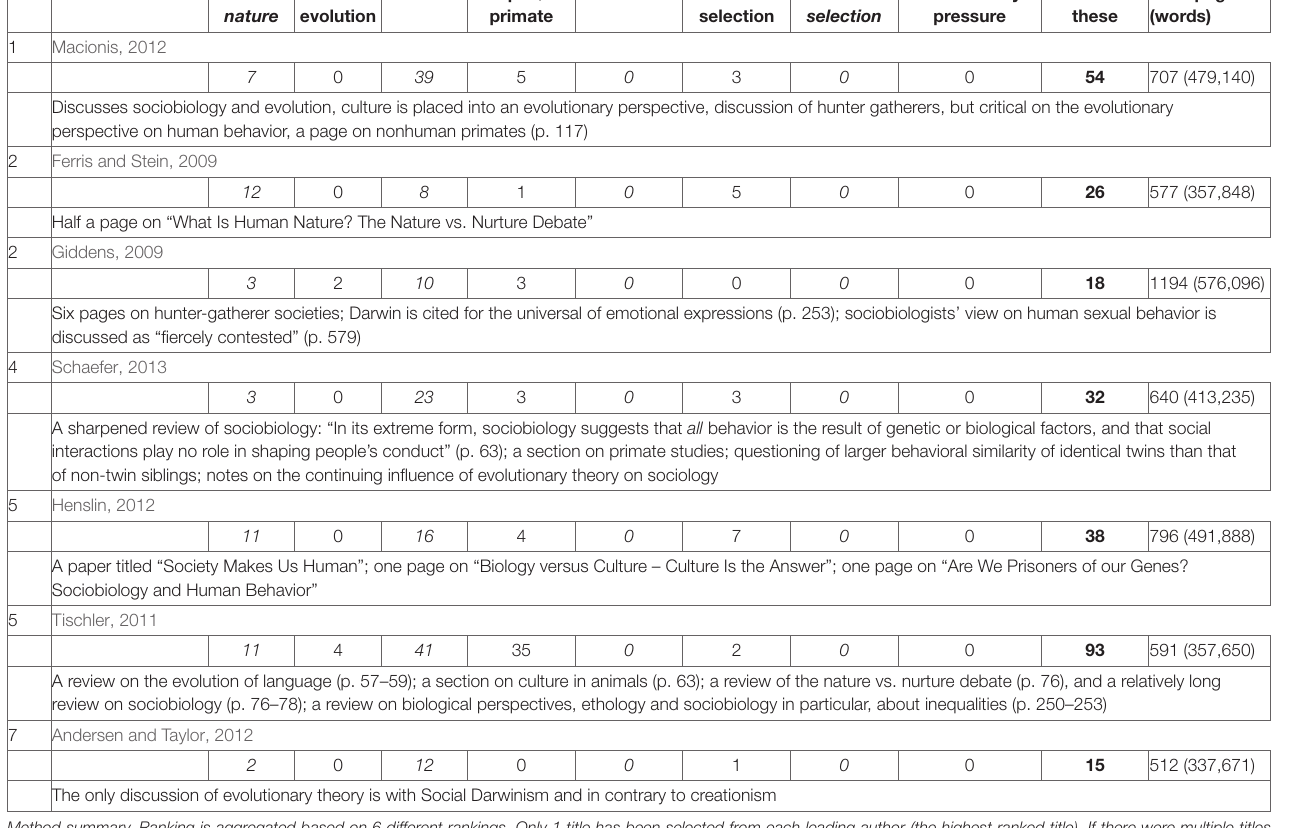
TABLE 1 | The take of the most relevant textbooks of sociology on evolutionary explanations: keyword frequencies.